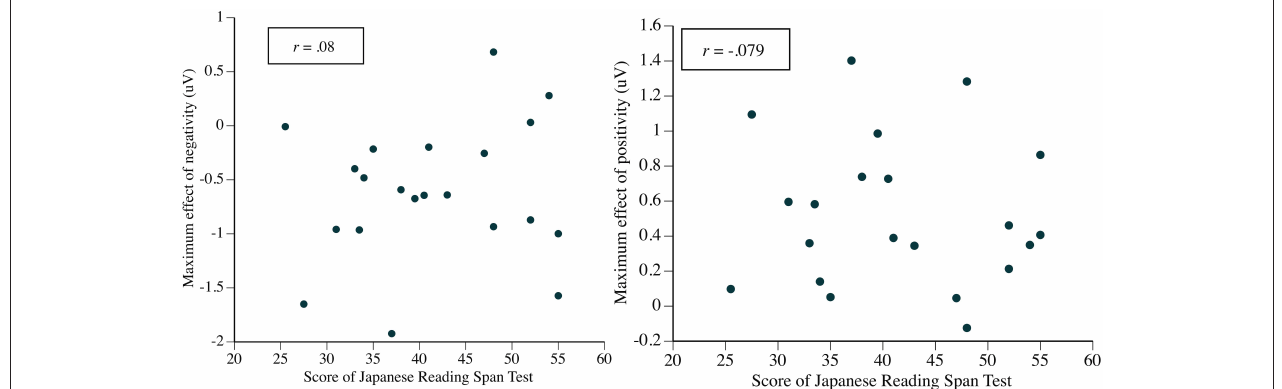
FIGURE 11 | The relationships between the ERP effects and the Japanese Reading Span Test scores across participants for the violation of a syntactic island constraint. Each point represents one participant. The maximum effects are the differences between In Syntactic Island and Control in Table 5 .